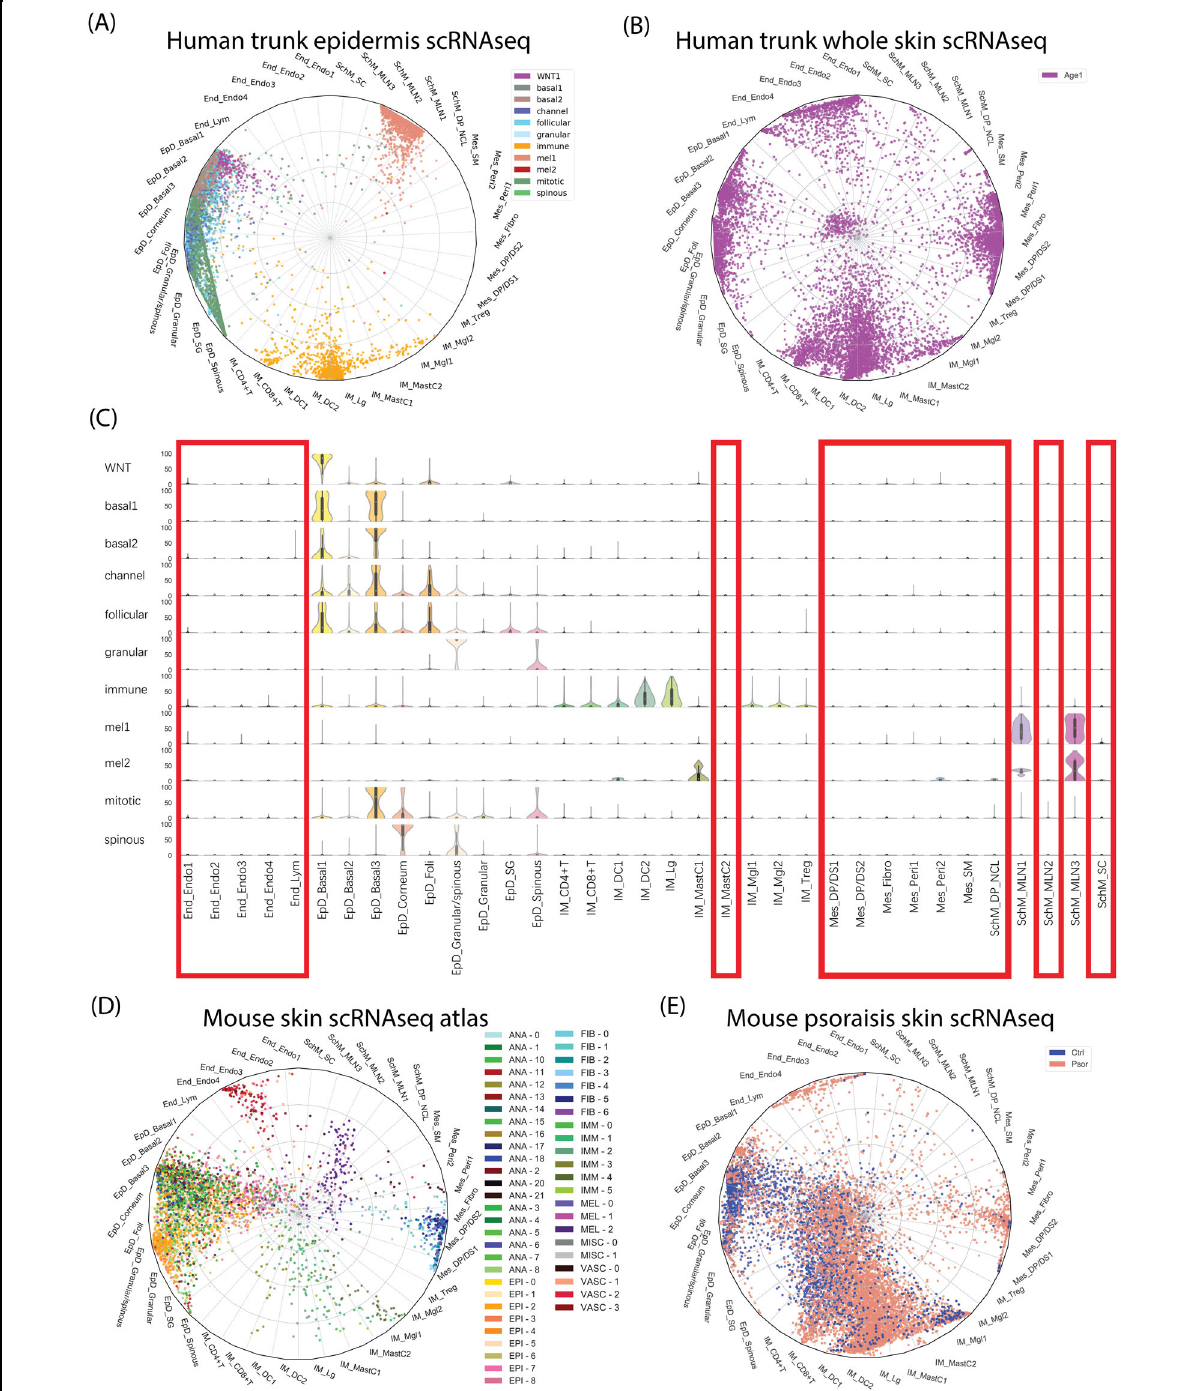
Fig. 2 Prediction of the anatomical location and evolutional conversation of human skin cell type. A Radar plot visualization of cell-type probabilistic scores of published human trunk epidermis skin cells in relation to our de fi ned cell types. B Radar plot visualization of cell-type probabilistic scores of published human full-thickness skin cells in relation to our de fi ned cell types. C Violin plot visualization of cell-type probabilistic scores of published human trunk epidermal skin cells in relation to our de fi ned cell types. X- axis represented our de fi ned cell types, y- axis represented de fi ned cell types from original study. Red frame indicated low similar (absent) cell types of our de fi ned cell types in epidermal skin cell types. D Radar plot visualization of cell-type probabilistic scores of published mouse skin atlas cells in relation to our de fi ned human skin cell types. E Radar plot visualization of cell-type probabilistic scores of published mice healthy or psoriatic skin cells in relation to our de fi ned human skin cell types. For all radar plots, each dot represented one cell. Color coding based on their original de fi ned cell clusters or disease condition. The position of each dot indicated the cell-type score between that cell and the training (de fi ned) cell types which were indicated outside of each bend in the radar wheel. Of fi cial journal of the Cell Death Differentiation